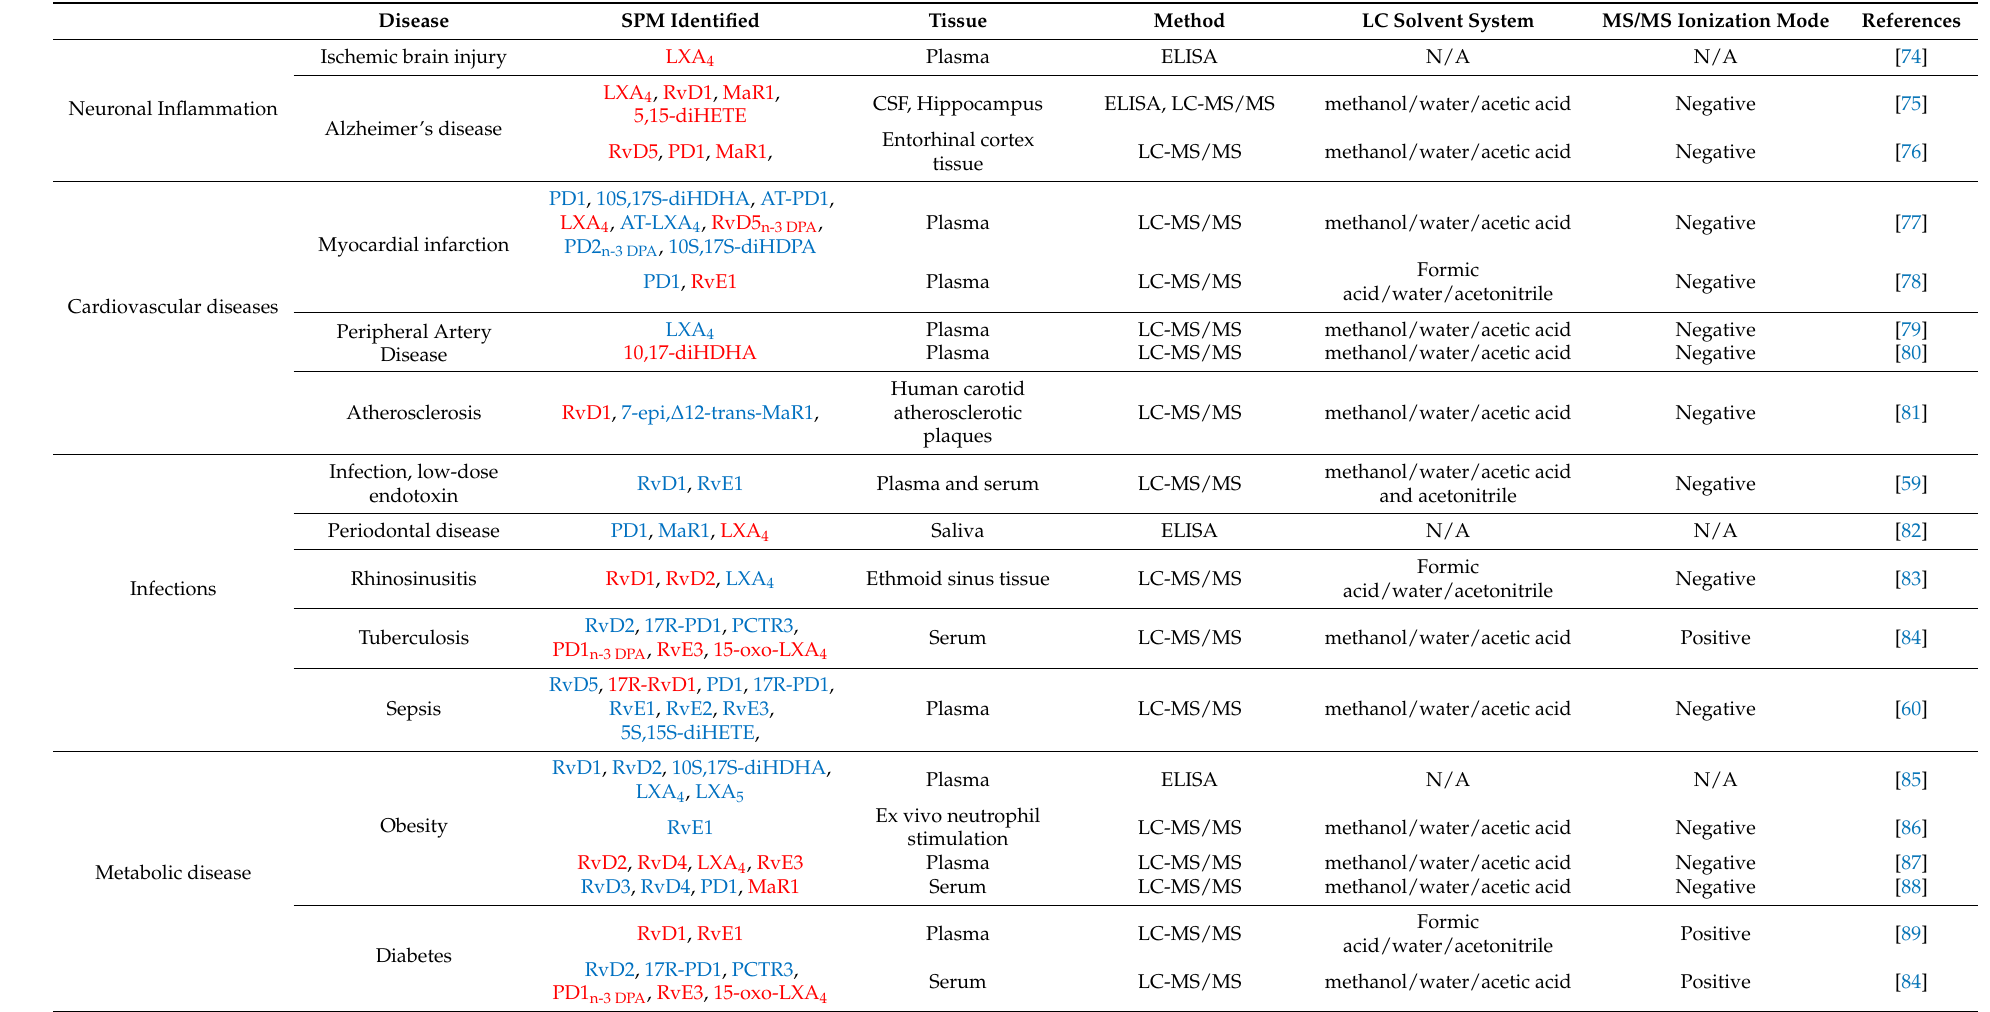
Table 2. Examples of specialized pro-resolving mediators identification in tissues from healthy volunteers and patients with inflammatory